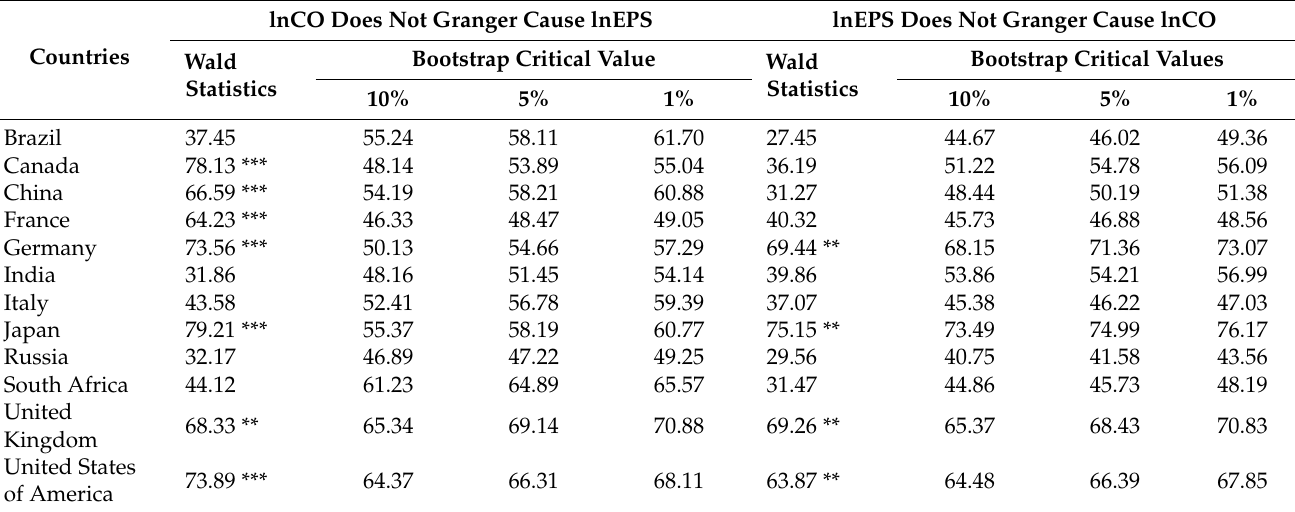
Table 8. The findings revealed a bilateral causality between CO and EPS for Germany, Japan, the United Kingdom, and the United States of America and a unilateral causality from CO to the EPS for Canada, China, and France. Table 8. Bootstrap Granger causality test between lnCO and lnEPS.